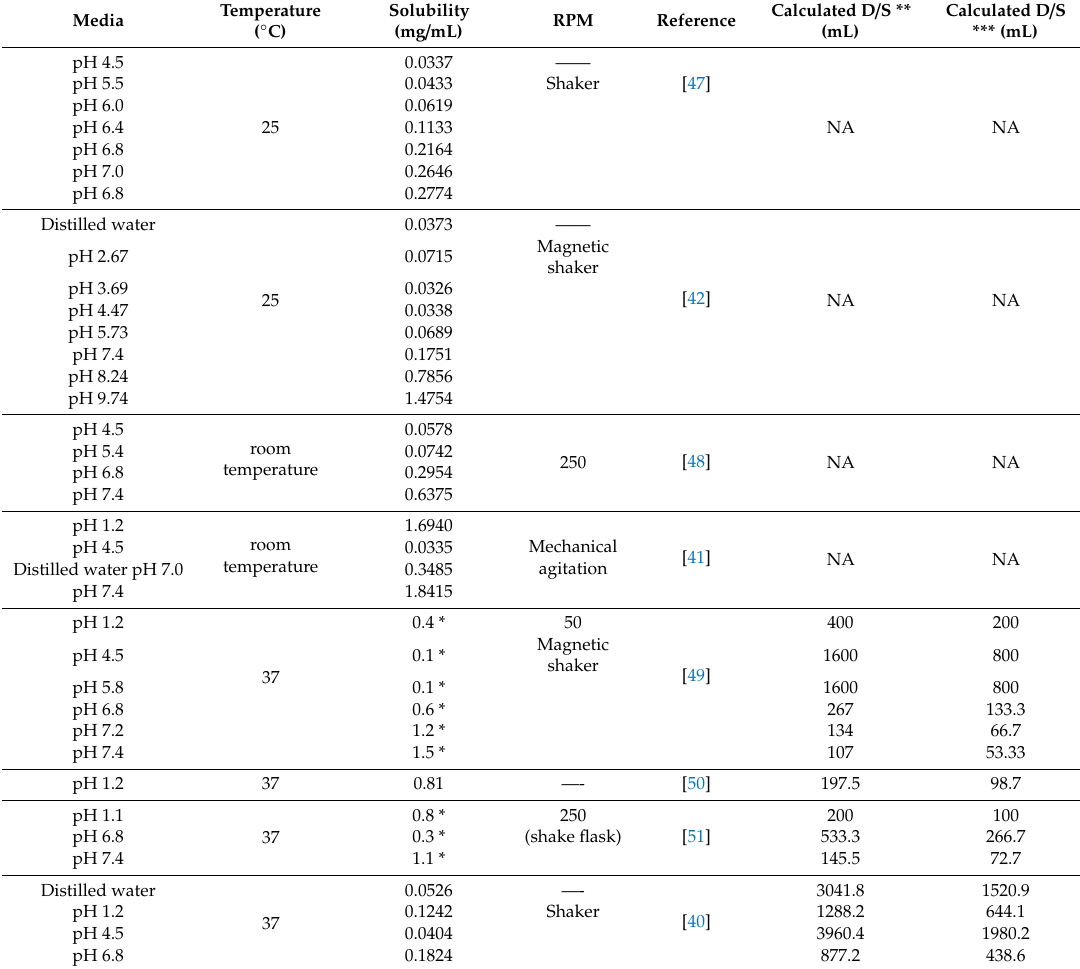
* Estimated values based on the graphic representation present in the referenced article. ** D / S: solubility dose ratio calculated based on the highest administered unit dose (160 mg) of gliclazide in solid oral dosage form (SUPAC-IR), for studies performed at 37 ◦ C [45]. *** D / S: solubility dose ratio calculated based on the highest commercialized dose (80mg) of gliclazide in SUPAC-IR, for studies carried out at 37 ◦ C [46]. NA: not